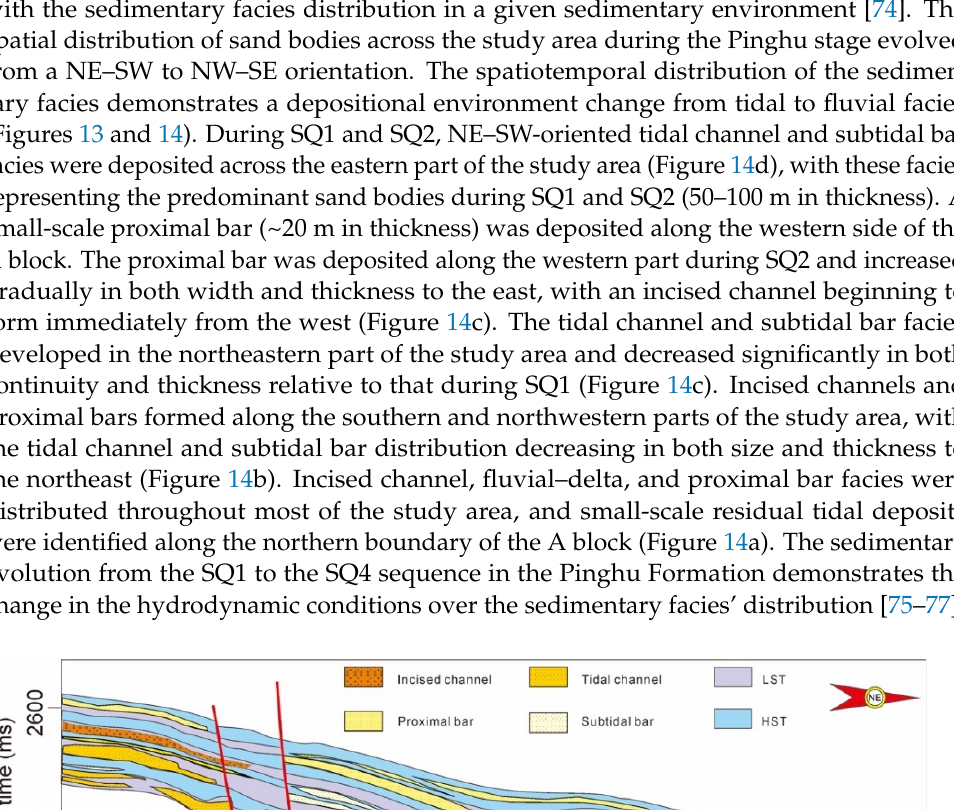
Figure 14. Horizontal distribution of sedimentary facies of the Pinghu Formation during ( a ) SQ4, ( b ) SQ3, ( c ) SQ2, and ( d ) SQ1 stage. The arrows indicate the relative location to the study area. The tidal currents, flood tidal currents, and ebb tidal currents often flow along the shoreline, such as in the tidal currents of the Jiangsu Coastal zone [78]. The Xihu Sag is a